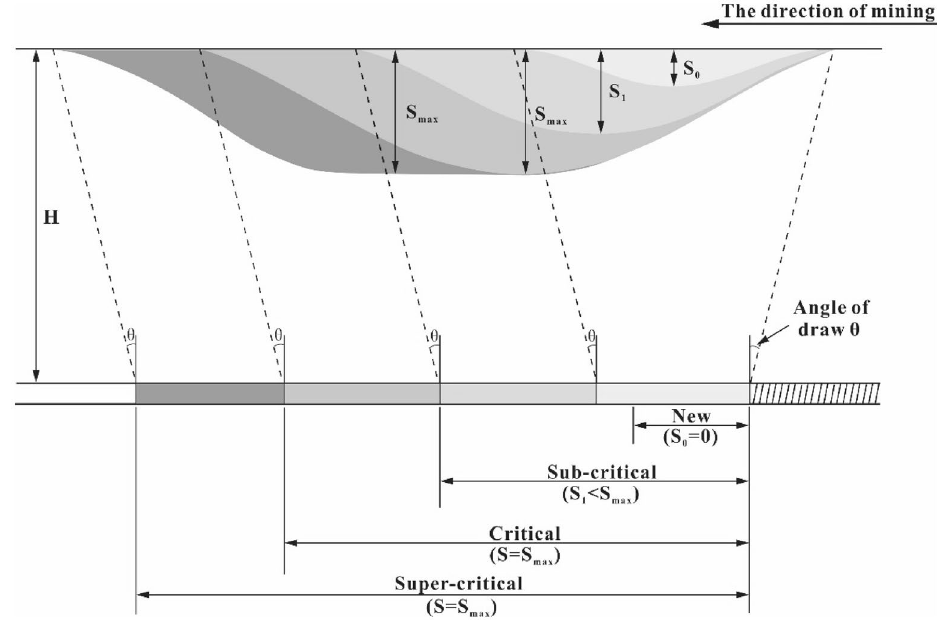
Figure 1. The vertical section sketch of coal seam mining